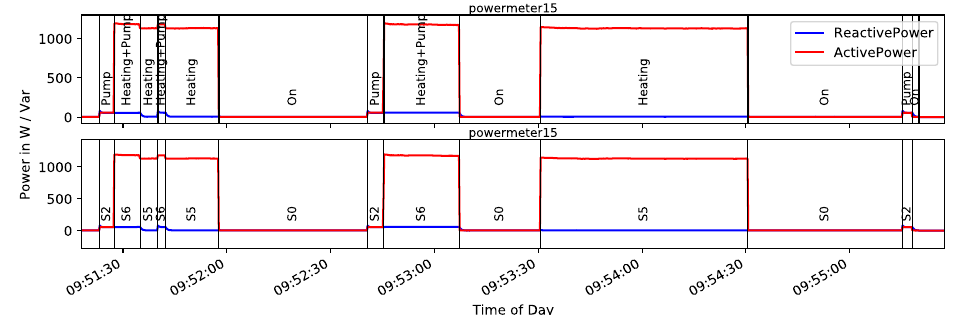
Figure 11. The fully labeled data of the espresso machine (30th of July at 9:50 a.m.). The bottom plot shows the initial labeling of the automatic labeling algorithm, while the top plot shows the final labeling after human supervision. (The rightmost event has been missed by the